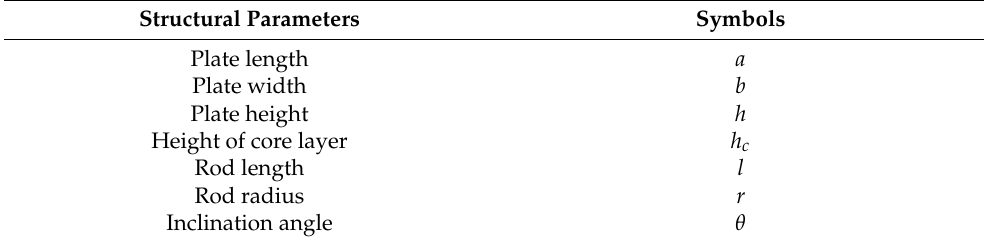
Figure 1. System model: ( a ) composite truss core sandwich plate excited by shock load; ( b ) the pyramidal truss core unit with the NES; and ( c ) the mechanical model of the NES. Table 1. The symbolic representation of structural